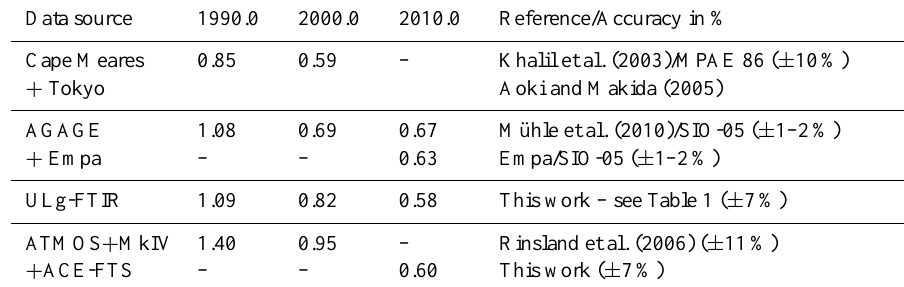
Table 3. Annual rate of increase expressed in pptyr − 1 for atmospheric CF 4 computed for three reference